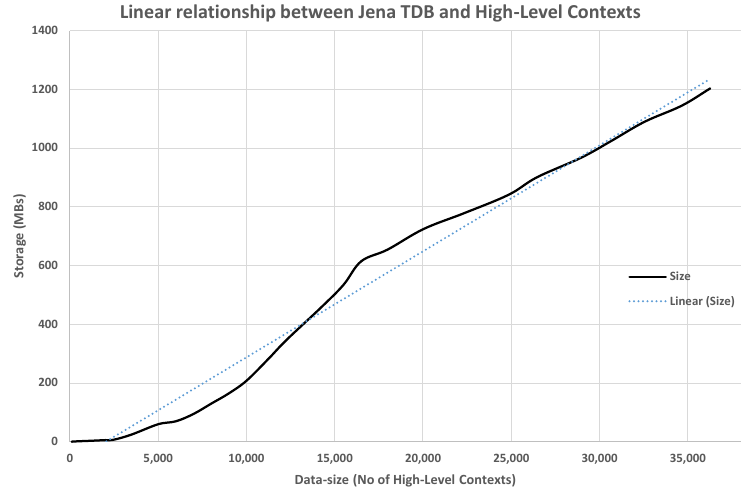
Figure 15. Unidentified PA-HLCs, and N-HLCs due to missing LLCs.